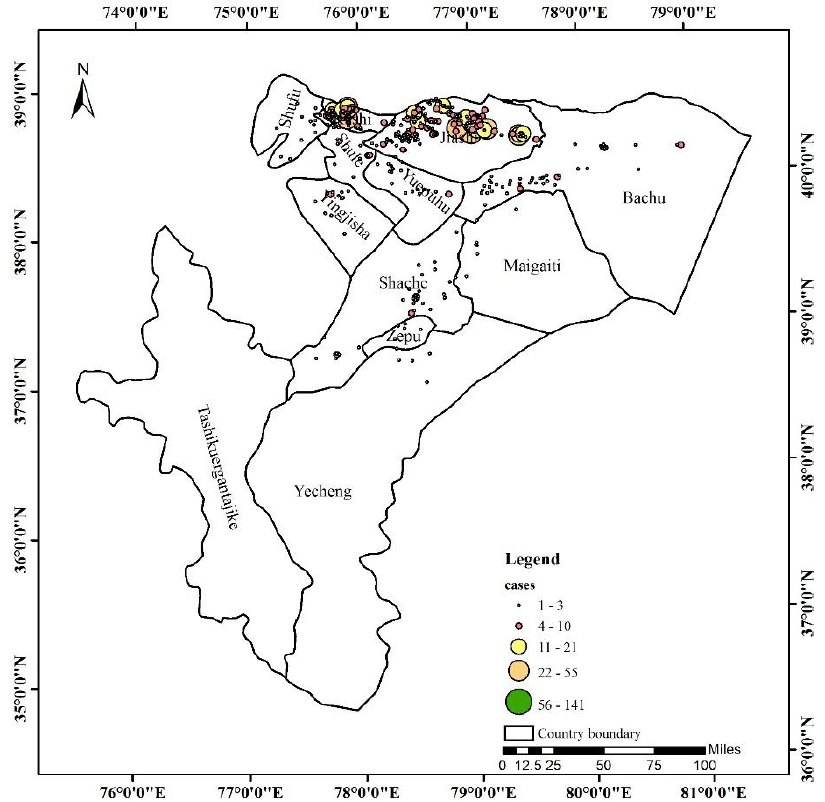
Figure 4. Geographical distribution of all VL cases between 2005 and 2017.